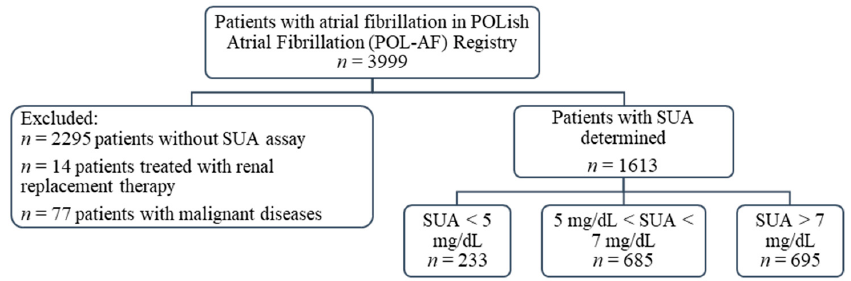
Figure 1. Flow chart of the study. Abbreviations: SUA, serum uric acid.